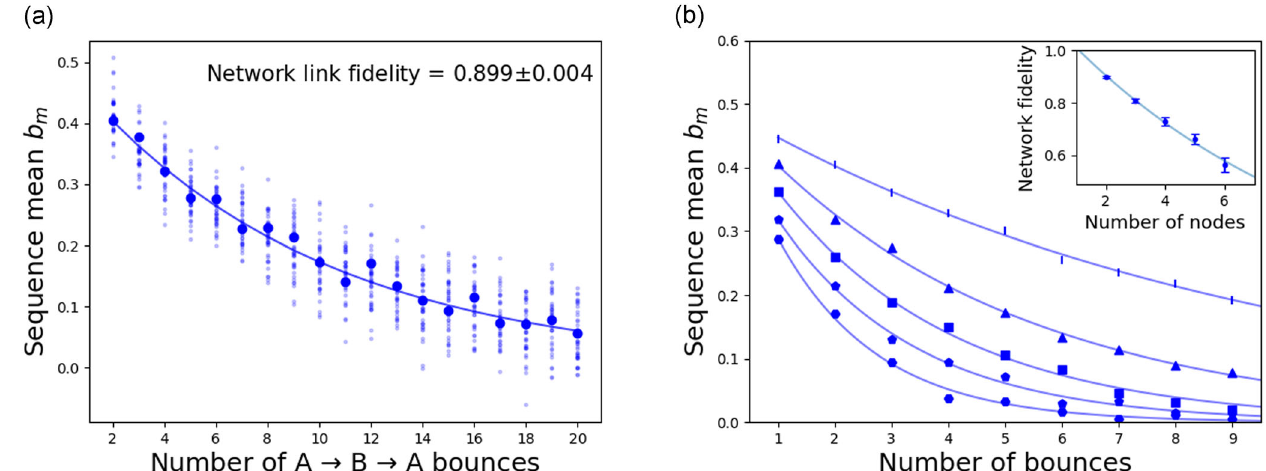
Fig. 2 Network benchmarking simulations using NetSquid. a Simulation in Netsquid of the two-node network benchmarking protocol (algorithm 1). The nodes A and B hold qubits af fl icted by dephasing ( T 2) errors, as seen in NV-center quantum processors 37 . The channels Λ A → B and Λ B → A emulate teleportation with a noisy quantum state of the form eq. (15), with a bright state population of α = 0.95. The error bar on the decay rate is a 95% Studentized con fi dence interval constructed from the fi t. b Simulation in Netsquid of the multi-node network benchmarking protocol (going from two (line markers) to six (hexagon markers) nodes in a linear con fi guration). The noise models for network links and node operations are as before. The error bars in the inset are 95% Studentized con fi dence intervals constructed from empirical variances. We observe that the network fi delity decays exponentially with the number of